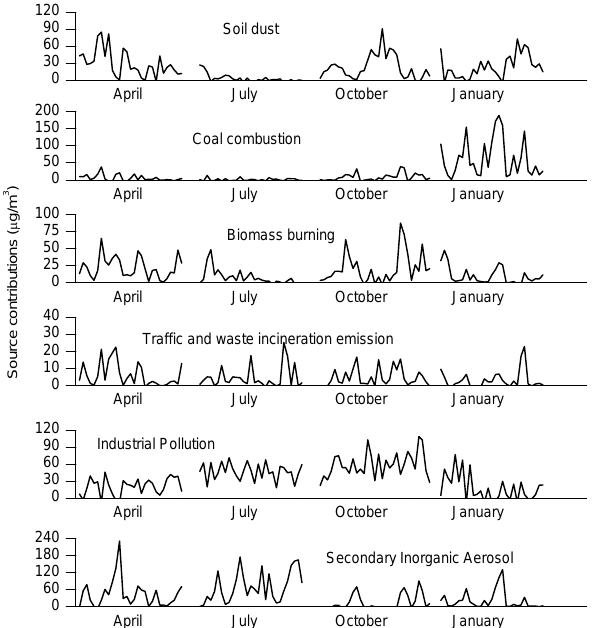
Figure 9 Fig. 9. Time series of daily contributions from each identified source, including soil dust, coal combustion, biomass burning, traf- fic and waste incineration emission, industrial pollution, and sec- ondary inorganic aerosol (from the upper to the lower panels) dur- ing the study period between April 2009 and January 2010.